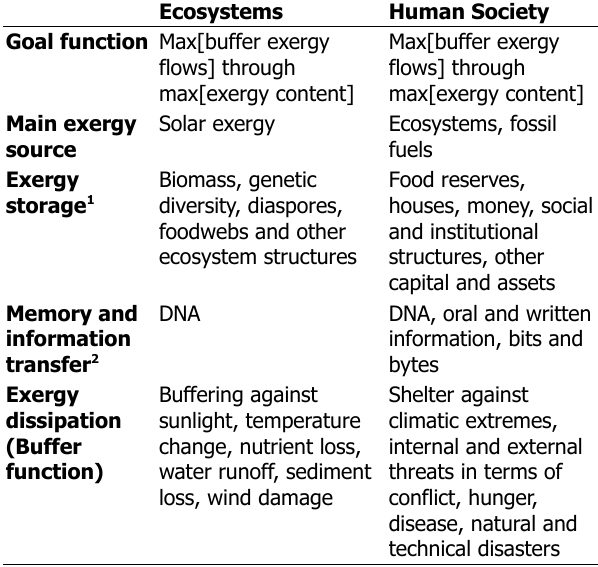
Table 1. The ecosystem exergy model of Schneider & Kay [24] as the universal goal function of complex self-organizing systems, here applied to ecosystems and human society, illustrating the analogy in structure and function between the two